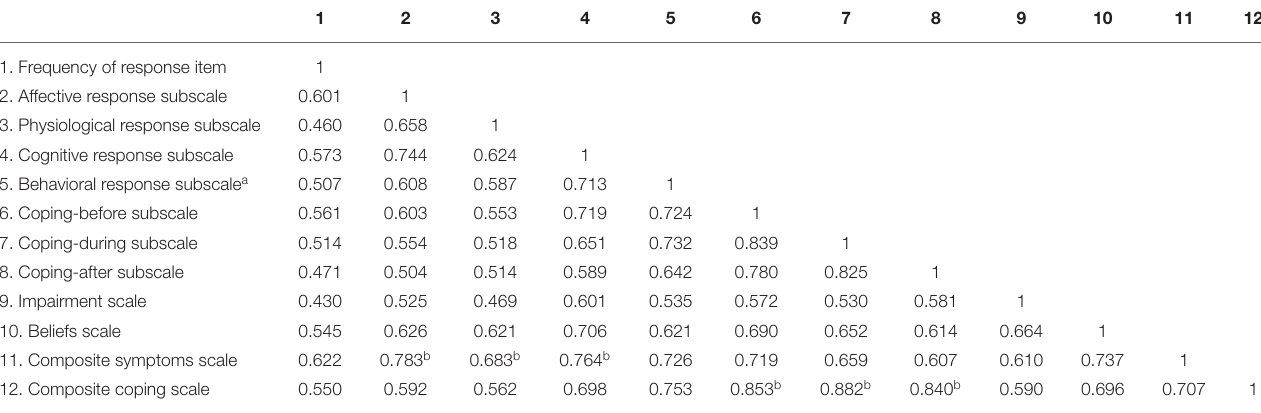
TABLE 4 | Correlations among subscale and scale scores of the Duke Misophonia